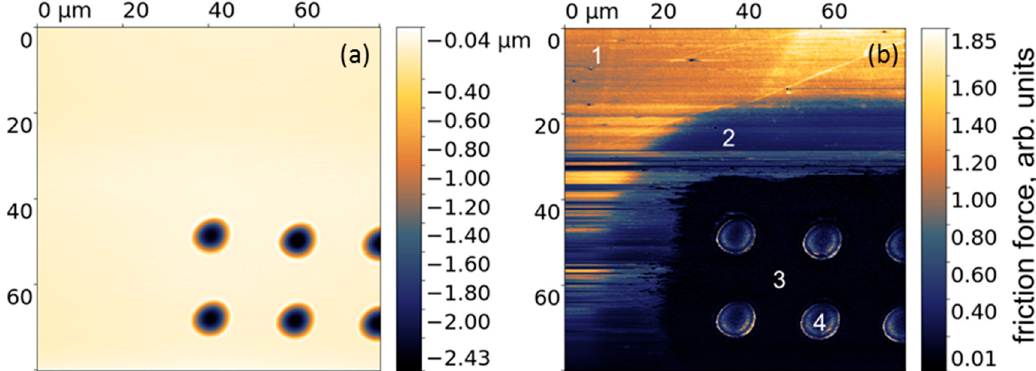
Figure 10. Surface relief ( a ) and friction force ( b ) images of the laser-patterned DLN film near the corner of a microcrater structure (shown in Figure 1a), load on Si tip ~120 nN. The marked points (1,2,3,4) in the FF image are the places of force–distance curves measurements, shown in Figure 11.